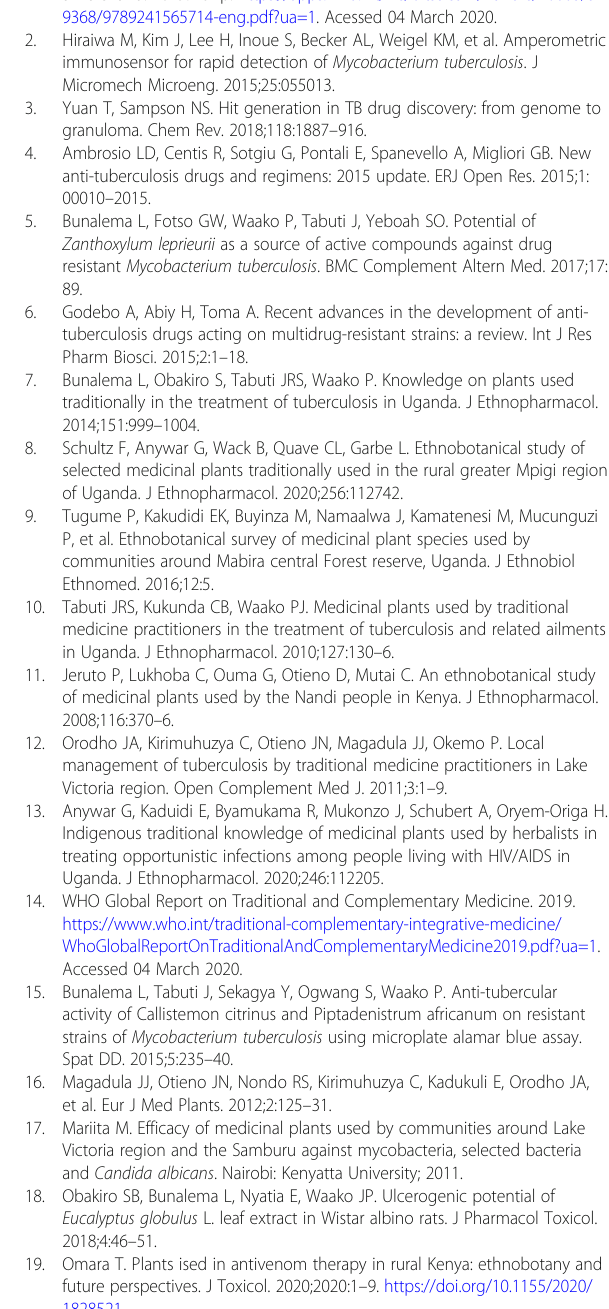
Additional file 1: Figure S1 . PRISMA flow diagram used for the